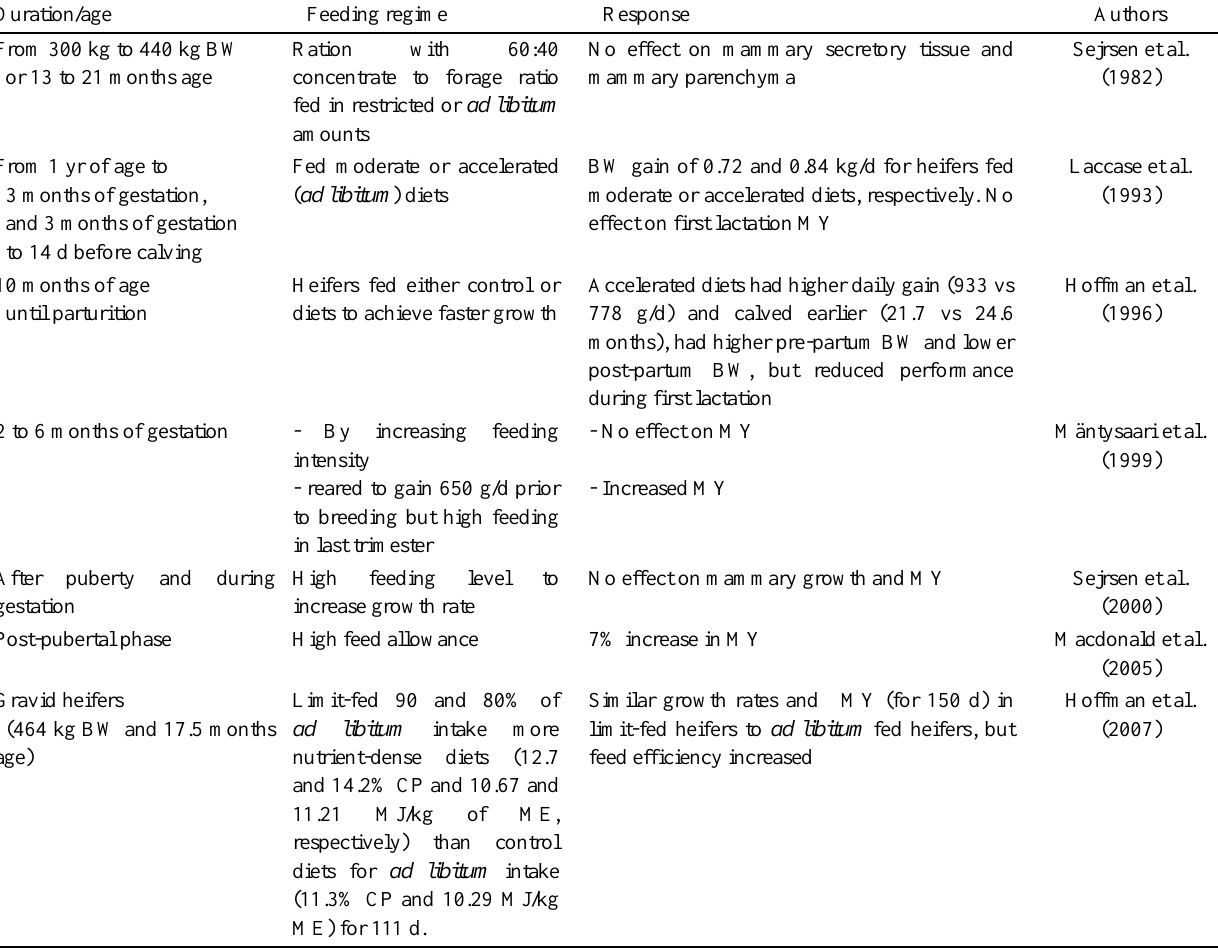
Table 3. Effect of post-pubertal feeding on heifer performance, mammary gland and milk yield